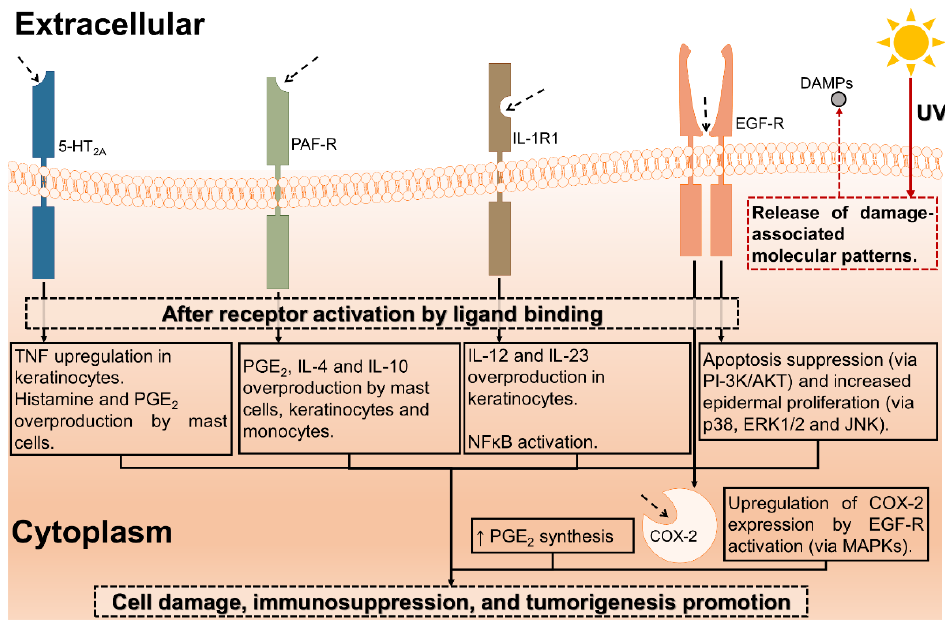
Figure 1. Schematic model of proteins involved in photodamage recognition and their inhibition sites. IL-1 receptor type I (IL-1R1), serotonin-receptor subtype 5-HT 2A , platelet-activating factor receptor (PAF-R), epidermal growth factor receptor (EGF-R), and cyclooxygenase-2 (COX-2) are crucial mediators in UV-induced carcinogenesis [12–16]. UV absorption by chromophores (e.g., cis - urocanic acid) induces the formation and release of damage-associated molecular patterns (DAMPs), which activate skin cell receptors with immunomodulatory effects (i.e., IL-1R1, 5-HT 2A , PAF-R, and EGF ‐ R). Arrows indicate locations of the binding sites for each target.